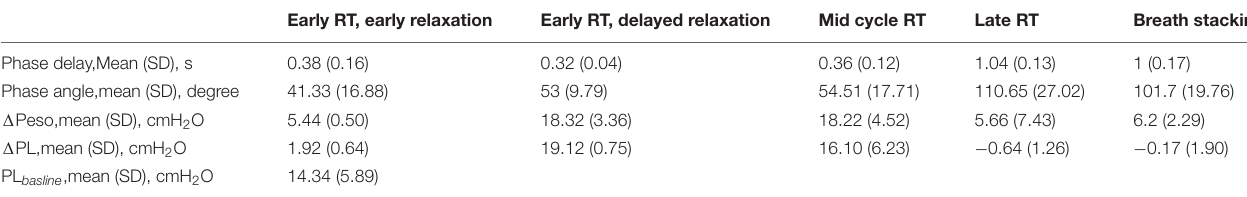
TABLE 3C | Phase delay, Phase angle and the (cid:49) Peso, PL in each phenotypes of reverse trigger.